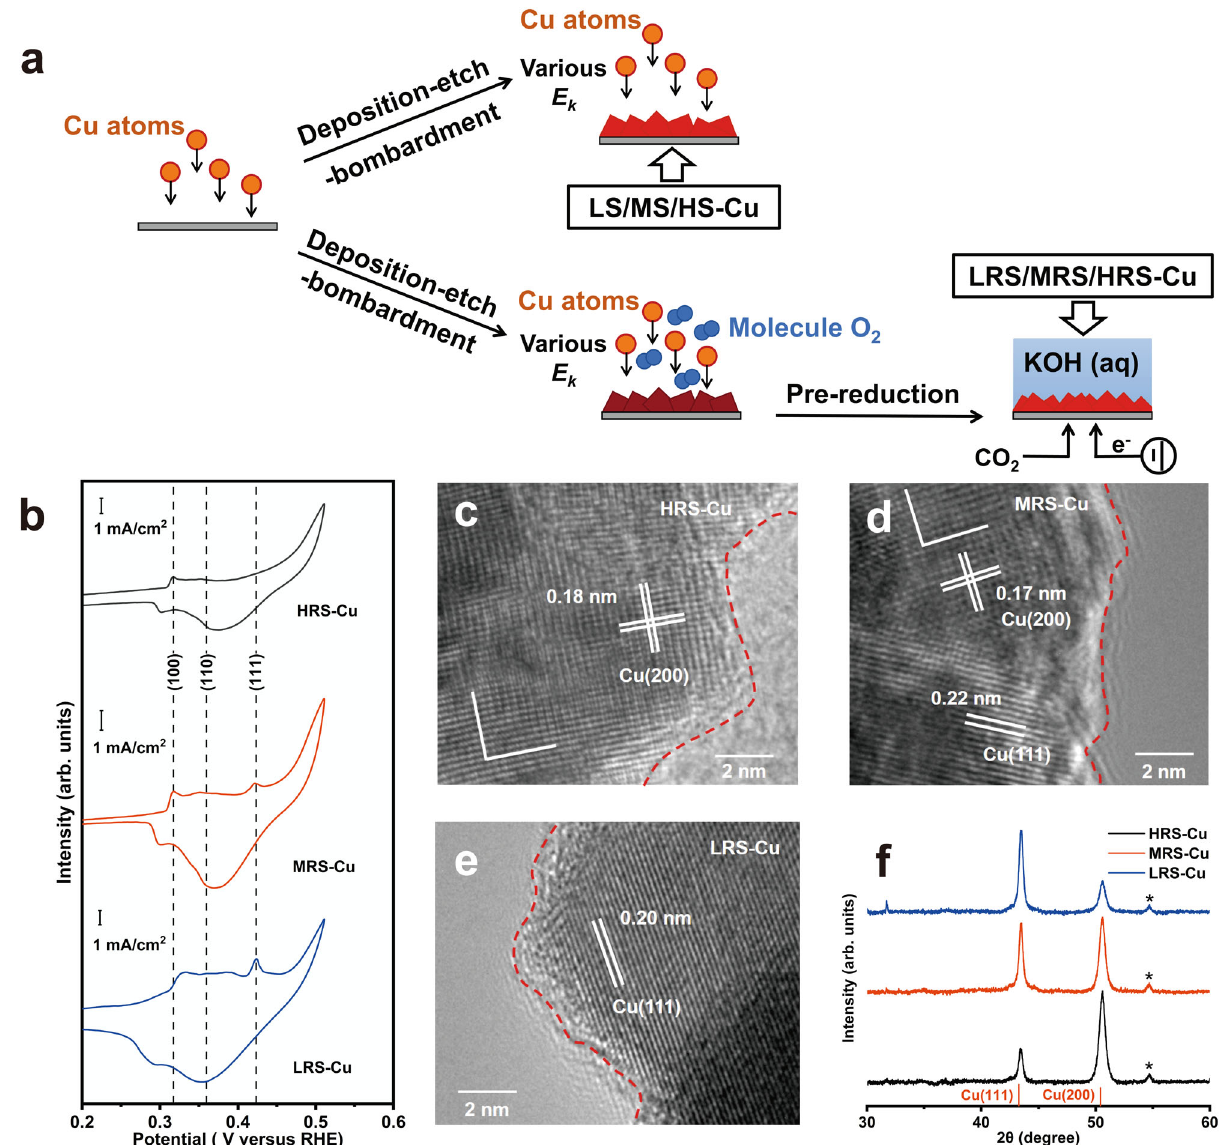
Fig. 1 characterization of various Cu fi lms. a A schematic illustration of the synthesis process for LS/MS/HS-Cu and LRS/MRS/HRS-Cu. b Voltammograms of resulting electrodes collected immediately after pre-reduction. Typical TEM images of c HRS-Cu, d MRS-Cu, and e LRS-Cu. f Typical XRD patterns of resulting electrodes. As visual aids, the red dash line indicates the surfaces of the resulting electrodes. The precatalysts of HRS/MRS/LRS-Cu were pre-reduced under − 0.5V versus the RHE for 1h, and the other conditions of prereduction are the same as that of the CO 2 reduction. The labeling of Cu(200) is used for easier comparison with XRD, in which only (200), the second-order diffraction of (100) could be detected. The peaks marked with an asterisk in XRD patterns originate from carbon-based GDL